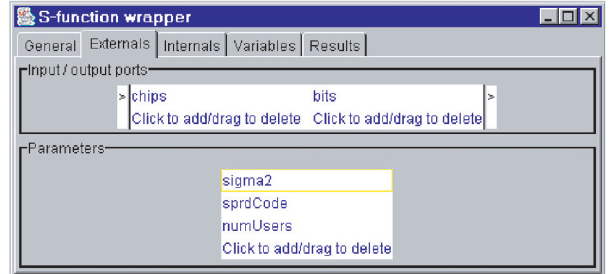
Figure 14: The GUI used to specify the type and sizes of in- put/output ports and parameters of an MMSE detector when “wrapping” the detector into a Simulink block. It implements the concepts discussed in Section 4.